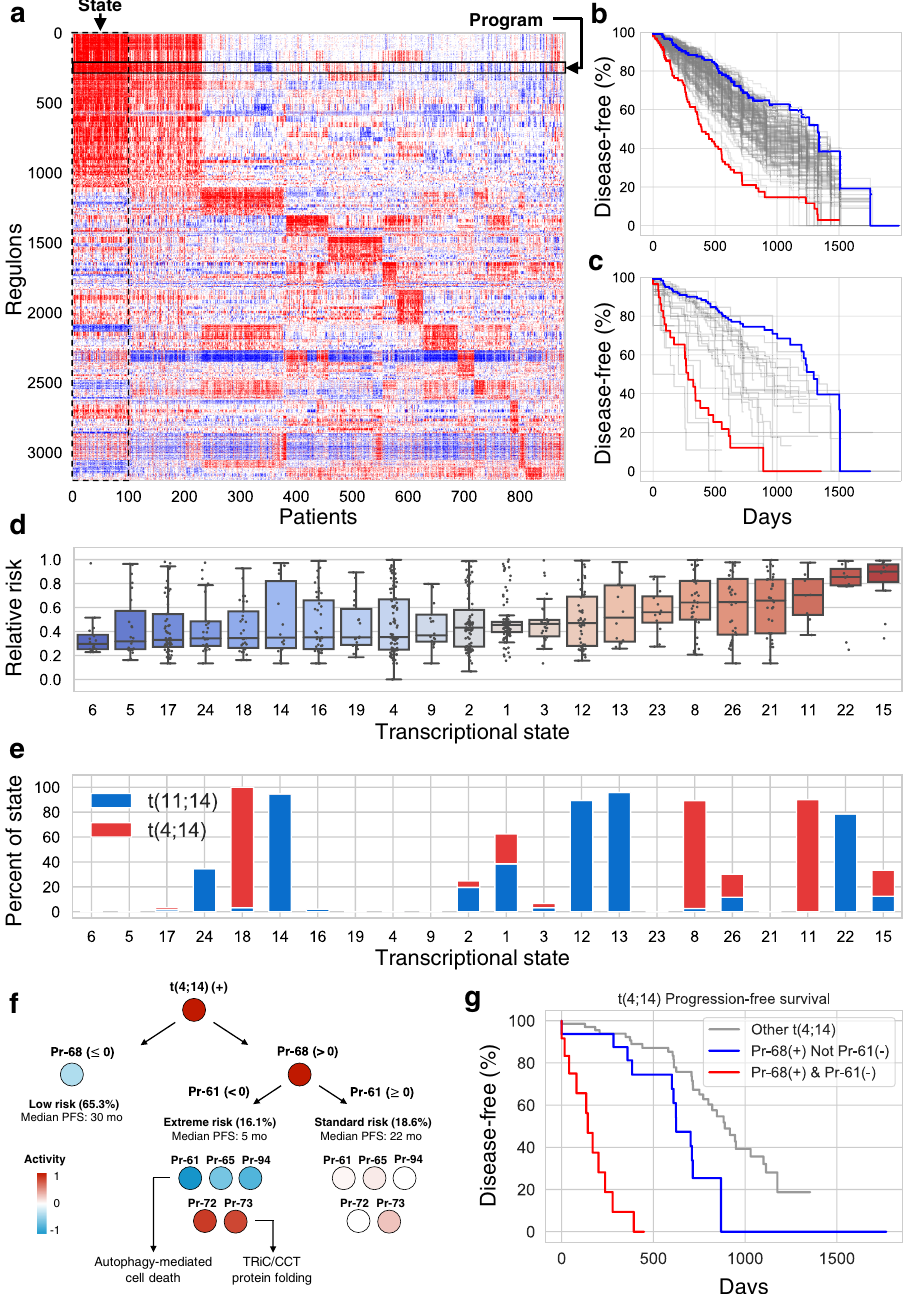
Fig. 2 Programs and states. a Heatmap of regulon activity across patients reveals distinct transcriptional states wherein patients have very similar regulon activity across the entire network. b , c Kaplan – Meier survival curves relating overexpression of each program ( b ) and state ( c ) to the observed progression-free survival in the CoMMpass study. The highest risk (red) and lowest risk (blue) programs are highlighted in ( b ). The four lowest risk (blue) and three highest risk (red) states are pooled to generate the highlighted curves in ( c ). d The risk distribution of each state according to the GuanRank of the survival data. States with fewer than fi ve patients represented in the survival data were omitted. Center line, median; box limits, upper and lower quartiles; whiskers, 1.5× interquartile range. e Patients with t(4;14) or t(11;14) fall into several distinct transcriptional states with varying risk of disease progression. f Program activity sub-strati fi es t(4;14) into standard and extreme-risk groups. g Kaplan – Meier plot of substrati fi ed t(4;14) regulon with all inferred target genes of MAF that are activated the clear existence of patient subtypes (i.e., transcriptional states) (i.e., no repressed target genes identi fi ed). MINER, on the other can be seen in the MINER regulons, but not in those discovered by hand, identi fi es several distinct MAF regulons, some of which are SCENIC (Supplementary Fig. 3). Inspection of a representative TF, activated by MAF and others that are repressed. The different MAF , and its regulons identi fi ed by SCENIC versus MINER sheds regulons are distinguished by distinct activity patterns across light on the regulon-level differences in activity and topology samples (i.e., biclustering). preservation (Supplementary Fig. 4). SCENIC identi fi es a single